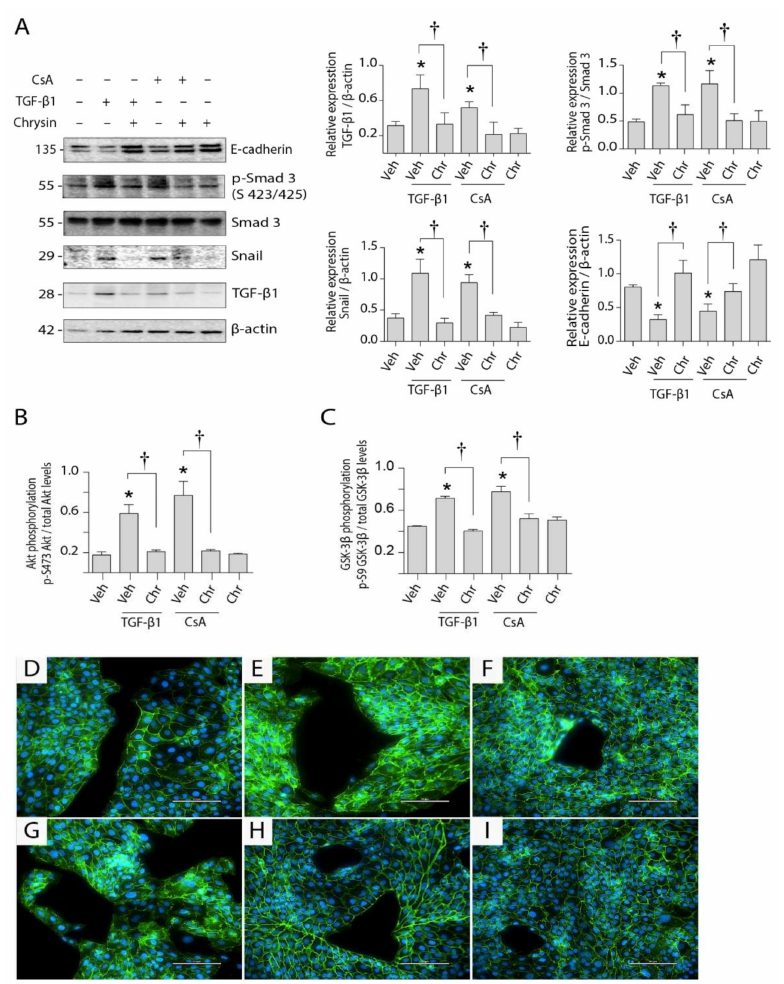
Snail and E-cadherin. Observations of TGF- β 1-associated non-Smad pathways indicated that chrysin co-treatment decreased phosphorylation of Akt at the serine 473 position (Figure 7B) and of GSK-3 β at the serine 9 position (Figure 7C), which were significantly increased after TGF- β 1 or CsA treatments alone. The total Akt and GSK-3 β levels were unchanged with the various treatments (data not shown). Additionally, intracellular localization of β -catenin was evaluated by immunofluorescence. The control cells had basal levels of β -catenin expression localized mostly to the cell–cell junctions (Figure 7D). Treatment with TGF- β 1 (Figure 7E) or CsA (Figure 7G) increased localization of β -catenin within the cytoplasm (white arrowheads), whereas co-treatment with chrysin inhibited increases in the release of membrane-bound β -catenin (Figure 7F,H).